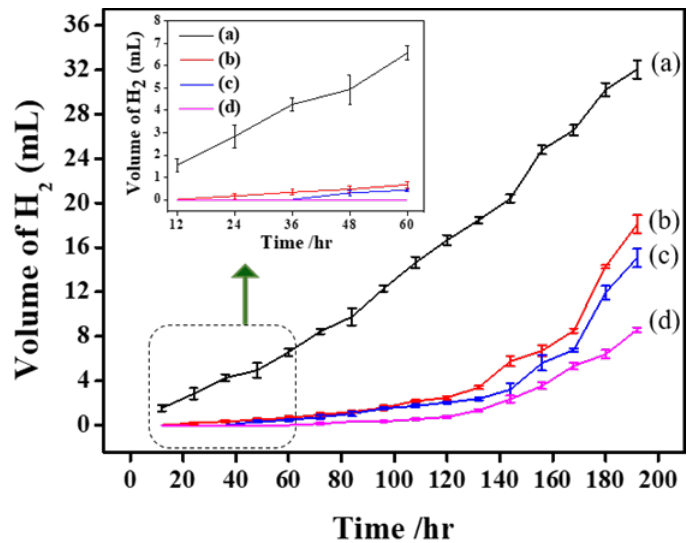
Figure 6. ( a ) Hydrogen evolution from ( a ) pure Mg, ( b ) Mg-OH, ( c ) Mg-OH-AA, ( d ) Mg-OH-AA-BSA substrate (n = 3). Inset shows the volume of H 2 gas evolved within 60 h.